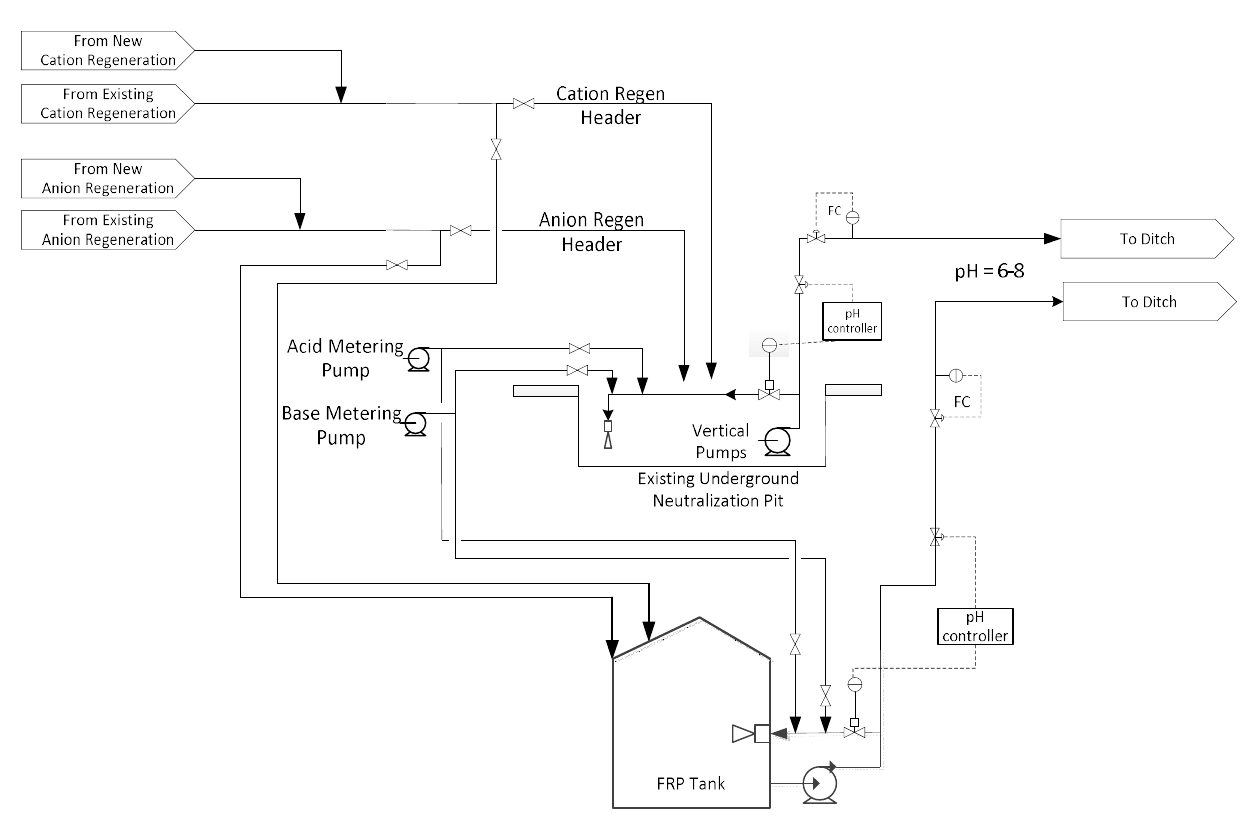
Figure 3. Improved neutralization process.